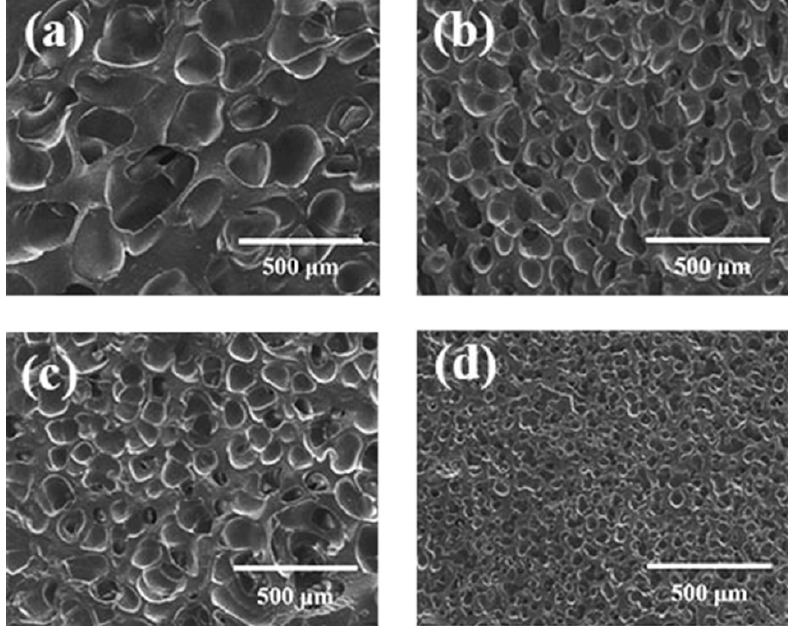
Figure 12. Cell morphology of foamed samples with different temperature-rising rates: ( a ) 5 ◦ C/min; ( b ) 10 ◦ C/min; ( c ) 15 ◦ C/min; ( d ) 20 ◦ C/min. The higher temperature-rising rate caused a higher cell density and smaller cell size. Table 7. Parameters of foamed samples with different temperature-rising rates.